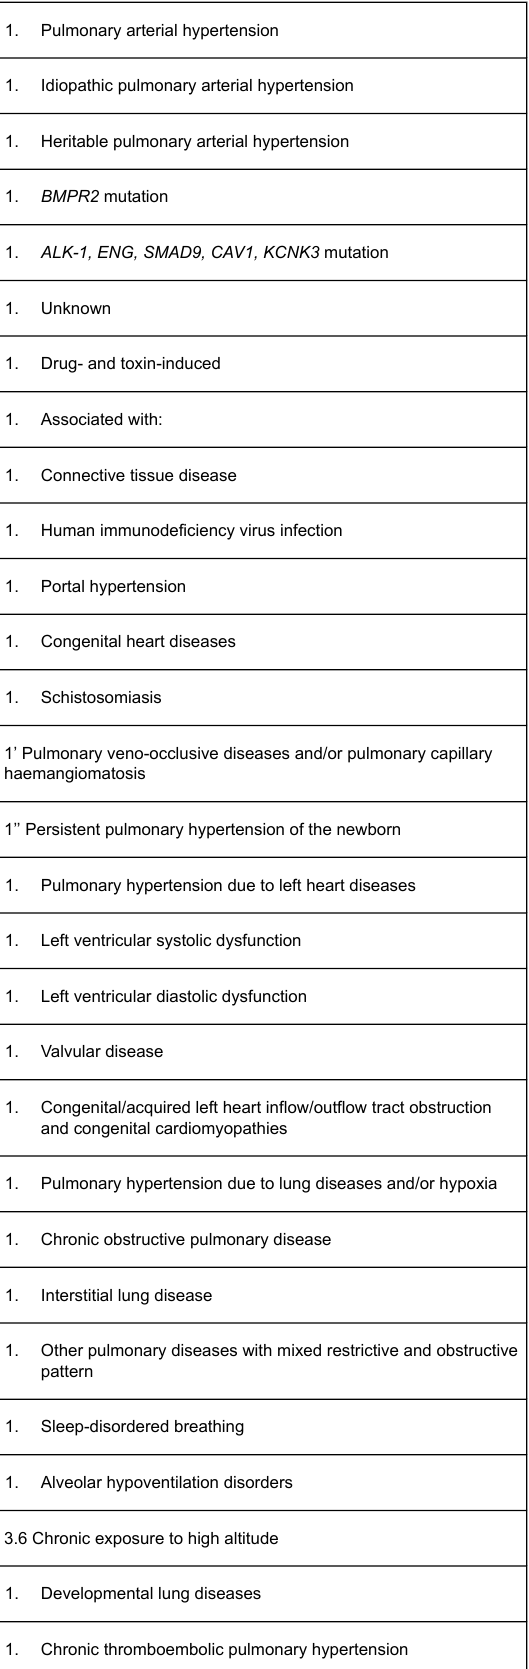
Table 1: Clinical classification of pulmonary